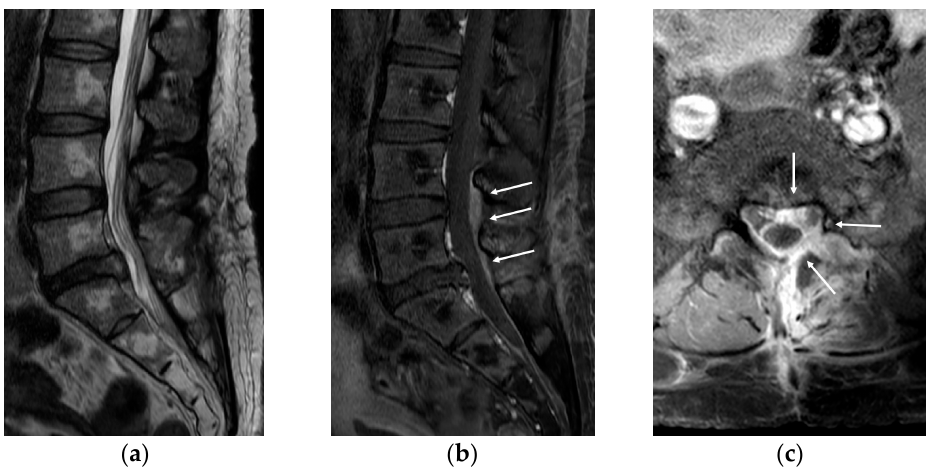
Figure 1. A 43-year-old woman presented with a radiating pain in her left lower extremity. ( a ) Mag- netic resonance imaging (MRI) showed left central herniated disc at the L5/S1 level. ( b ) Computed tomography (CT) revealed a combined posterior ring apophysis fracture at the same level.